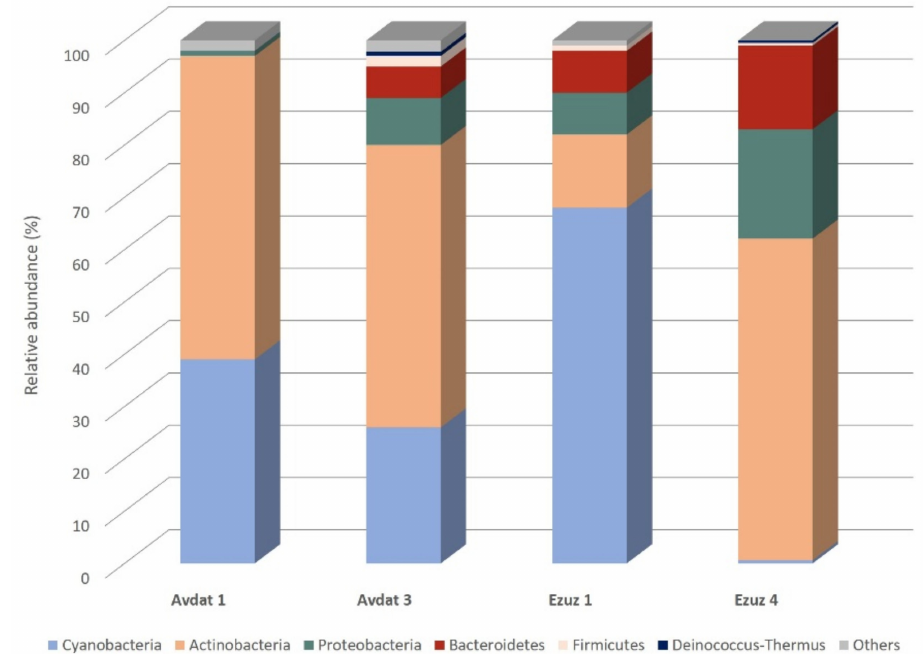
Figure 3. Relative abundance of bacterial communities at the phylum level (cutoff